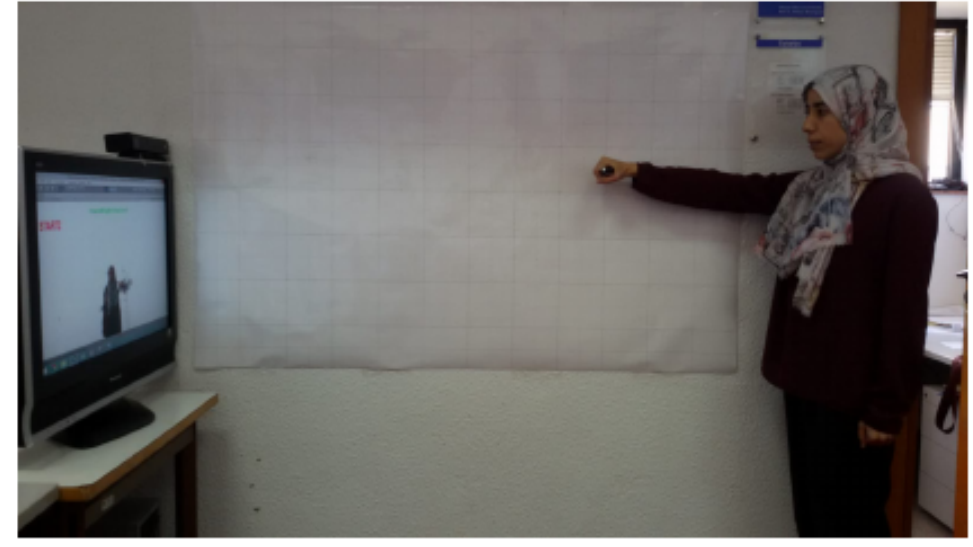
Figure 4. Settings of the